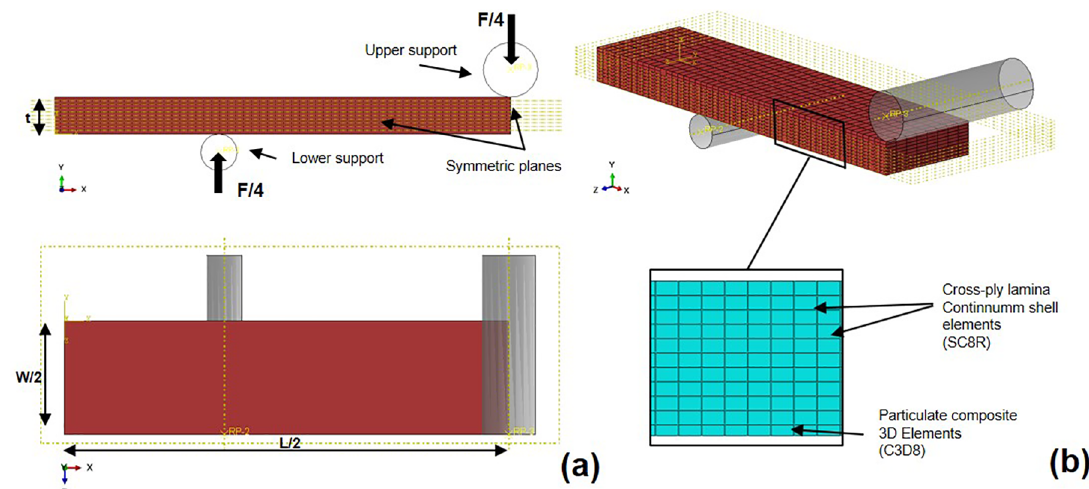
Figure 2. Three-point bending analysis of the composite laminate: (a) FE model and (b) mesh